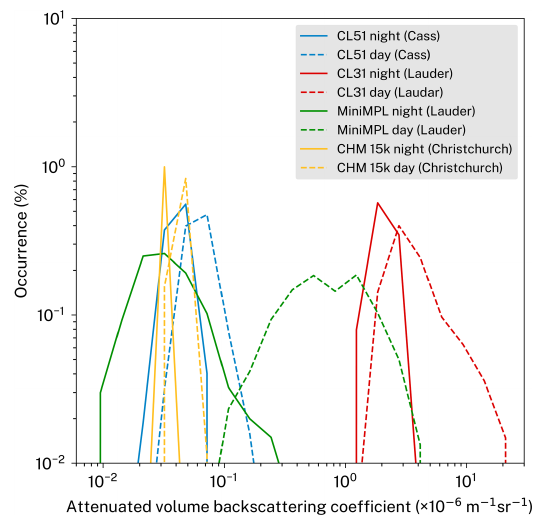
Figure 9. Attenuated volume backscattering coefficient noise stan- dard deviation histogram calculated for each instrument for sites in the case studies from clear-sky profiles over the whole time pe- riod. The noise distribution is calculated at the furthest range. The range-scaled noise distribution is shown at a range of 8km. “Night” and “day” distributions are calculated separately from nighttime and daytime profiles